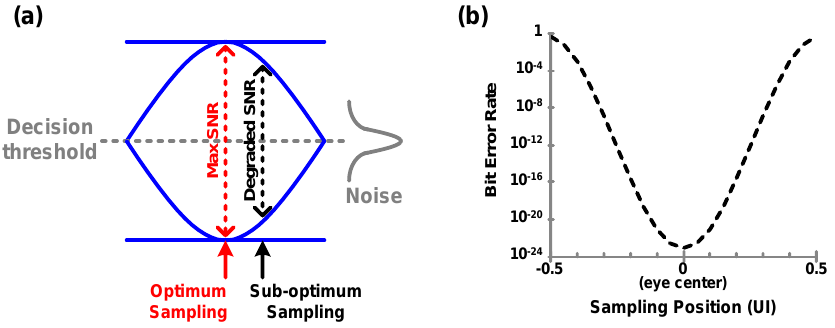
Figure 41. Dependency of BER on sampling timing. ( a ) Qualitative explanation of BER degradation and ( b ) quantitative relation of BER with sampling timing using the formula in [105].